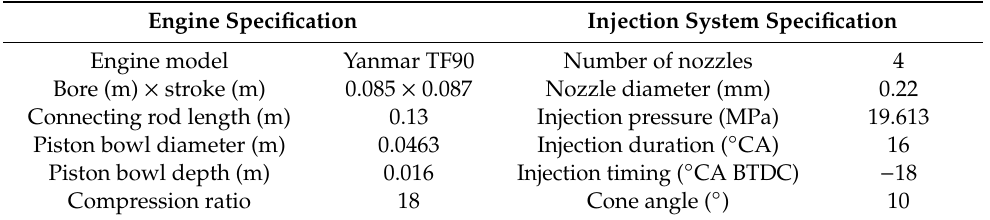
Table 2. Engine and injection system specification [15].